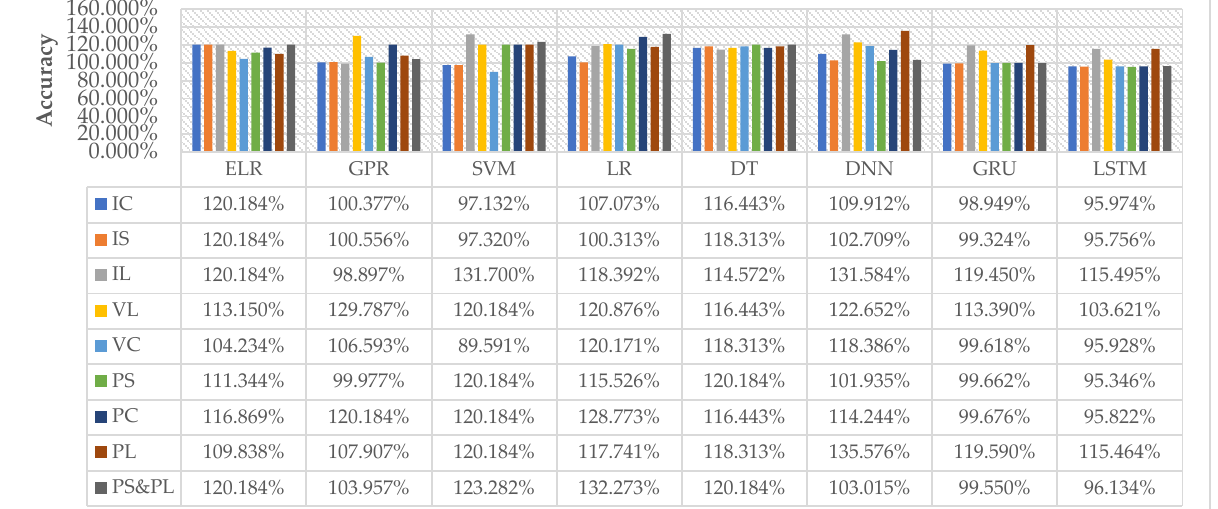
Figure 14. Average accuracy of the estimated equivalent series resistance ( ESR ) using discrete wave- let transform (DWT) analysis . Figure 15 presents the comparison of all input signals. The load signals (load current, voltage, and power) showed poor performances when their average accuracies were far